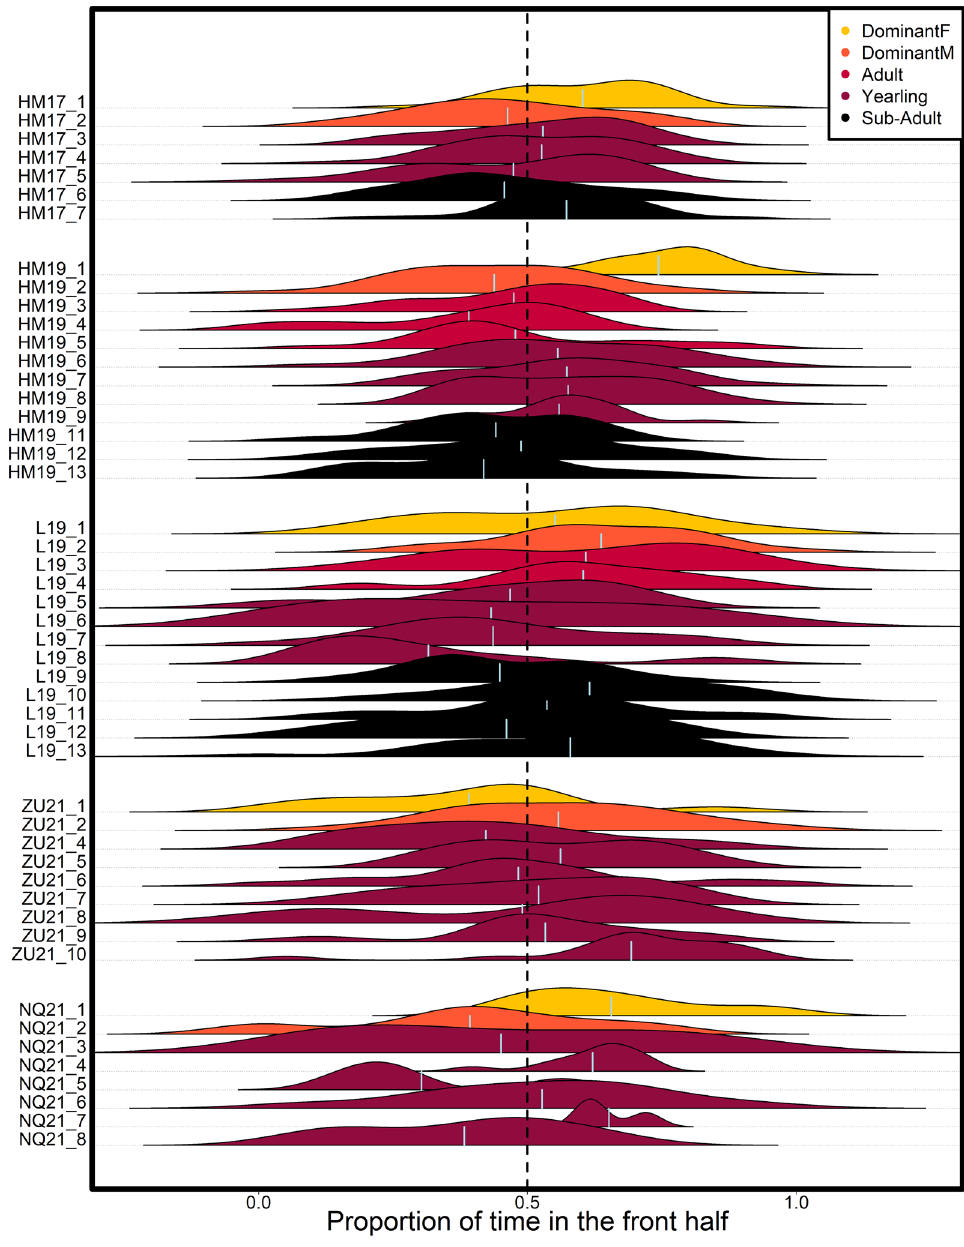
Figure 3. Distribution of the proportion of time spent in the front half of the group over 1-h time periods, for each individual in the 5 study groups (vertical axis). Color indicates individual status, light vertical lines within each distribution indicate the overall mean proportion of time spent in the front half of the group for that individual. Vertical dotted line indicates equal amount of time spent in the front and in the back half of the